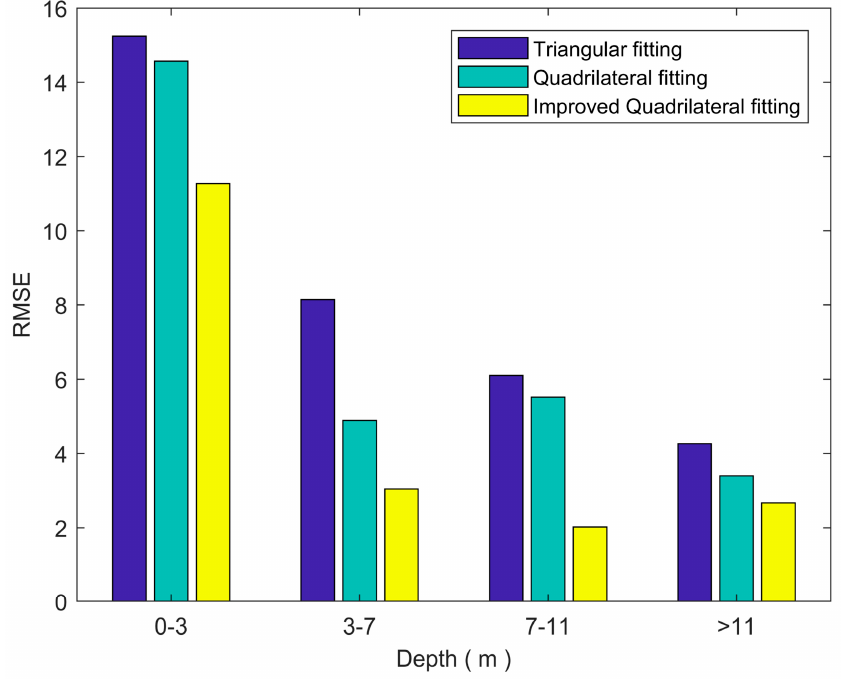
Figure 9. The depth distribution of the RMSE value for the three algorithms.